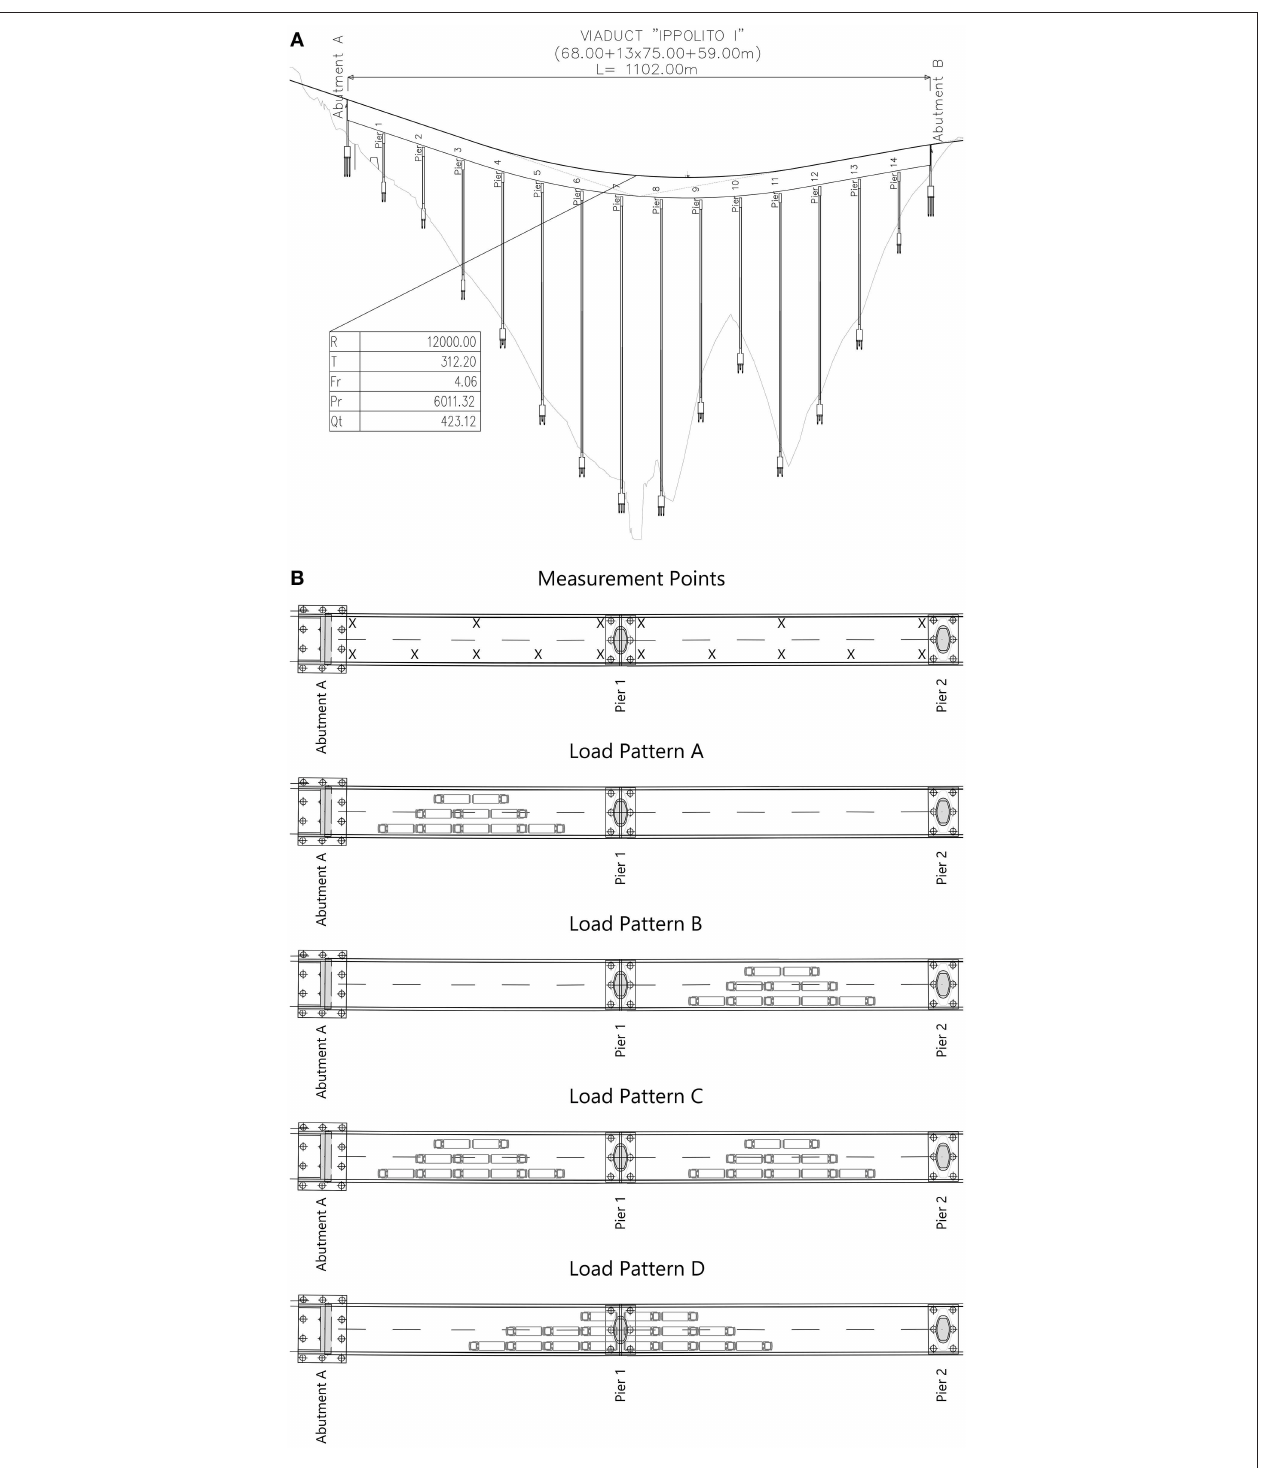
FIGURE 8 | Viaduct “Ippolito 1”: (A) longitudinal section; (B) load combinations of the first and second span.